Question: Express in one sentence what the figure is showing.
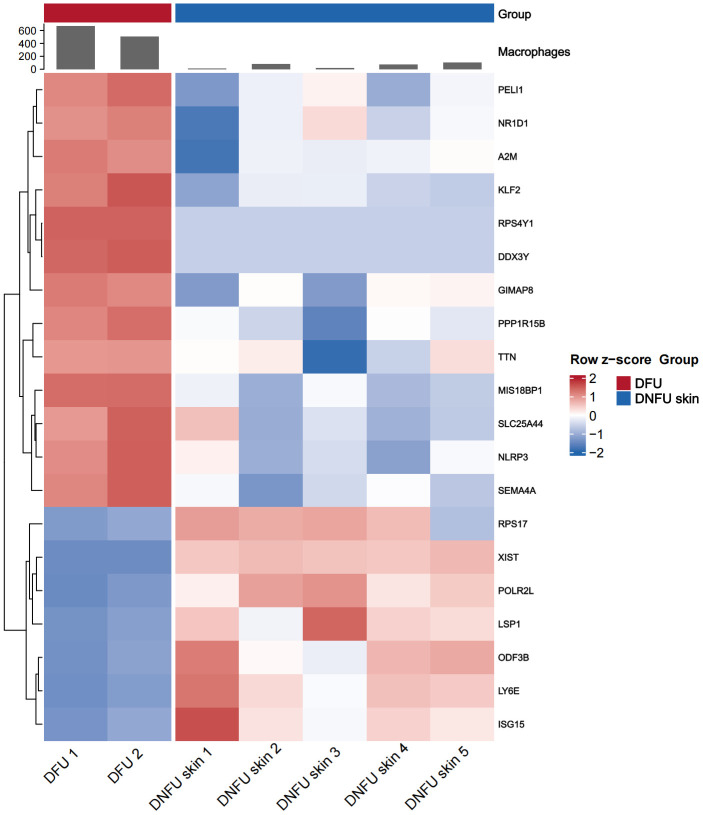
Answer: Macrophage pseudobulk differential expression heatmap. Heatmap of representative macrophage pseudobulk differential-expression genes for the DFU-versus-DNFU skin comparison. Pseudobulk differential expression was performed with edgeR using macrophage-containing samples that met the prespecified minimum threshold of 15 macrophages per sample, yielding 7 samples in total (2 DFU and 5 DNFU skin samples). Genes shown were selected from the top-ranked macrophage differential-expression results, and expression values are displayed as scaled expression across pseudobulked macrophage profiles.